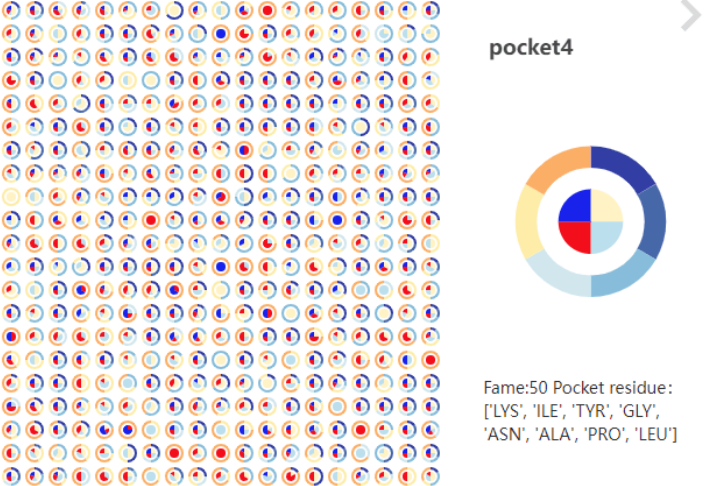
Figure 12. ( Left ): The hydrophobicity and polarity of pocket 4 at 1000 timesteps. ( Right ): The hydrophobicity and polarity of pocket 4 at the 50th timestep; the neighboring amino acids of the pocket were shown below.